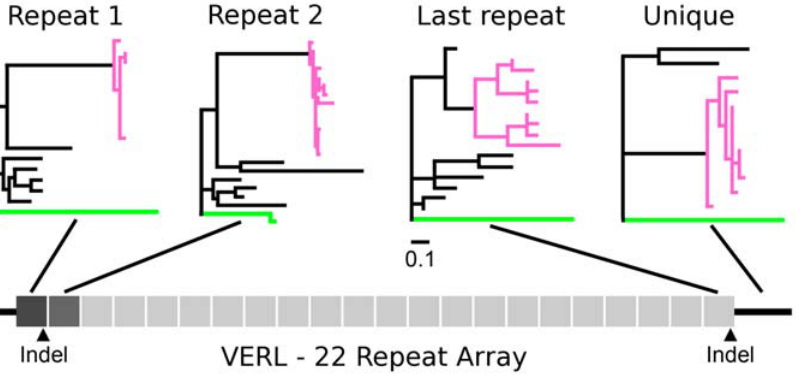
Figure 1. Variation in polymorphism between VERL repeat units and species. Phylogenies of each segment of VERL sequenced in this study: repeat 1, repeat 2, the last repeat, and the unique C-terminal region. Pink and green branches represent alleles from the pink and green abalone species. Other species and internal branches are shown in black. The repeat unit phylogenies contain a total of 8 species, and the ‘unique’ region has 4 species. While the pink population contains several alleles, the green population contains only two. Repeat unit types 1, 2, and 3–22 evolve independently. Repeats 3–22 evolve by concerted evolution and are represented by the last repeat. Note the deep divergence in the last pink repeat unit relative to other regions of VERL. Black arrowheads indicate the positions of two unrelated, 11-amino acid indels in the pink population.